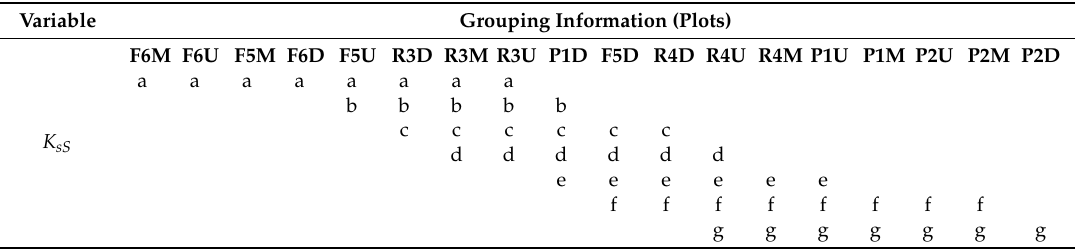
Table 2. Results of the Tukey honestly significant difference test ( p = 0.05) for the ln-transformed saturated hydraulic conductivity values estimated with the SSBI method ( K sS ). The grouping information highlights the significant and not significant